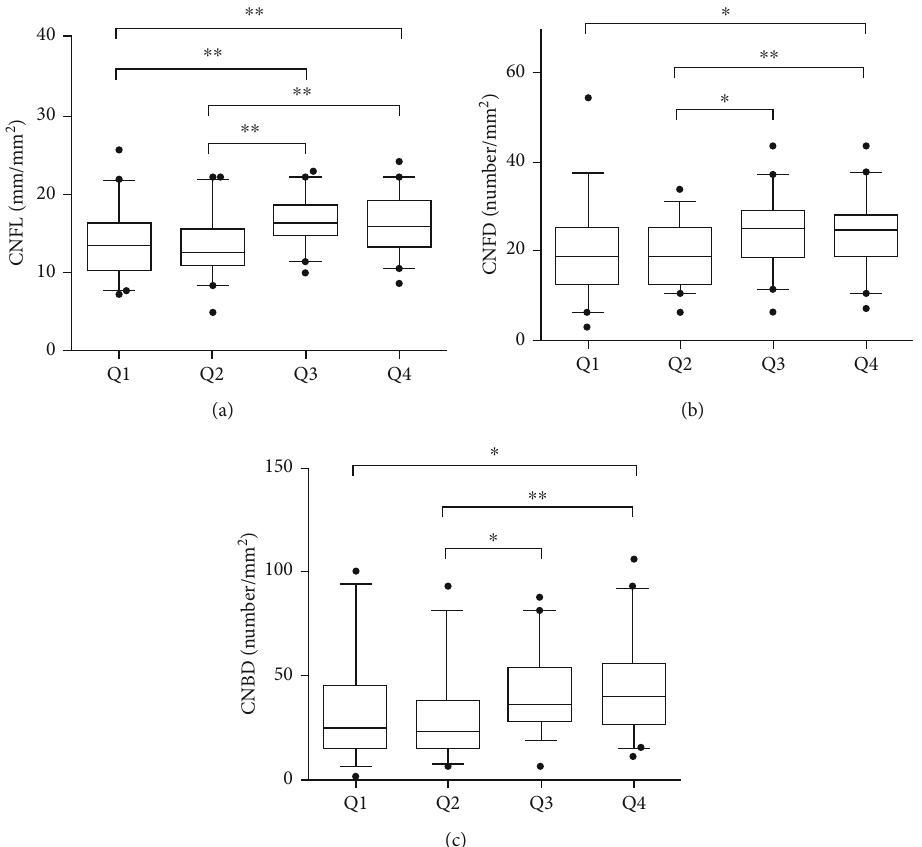
Figure 1: Di ff erences of CNFL, CNFD, and CNBD between groups based on the quartiles of fasting C-peptide levels. ∗ P < 0 : 05 and ∗∗ P < 0 : 01